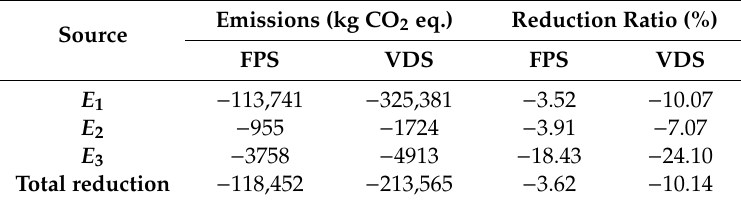
Table 6. Reduction of the total carbon dioxide emissions.